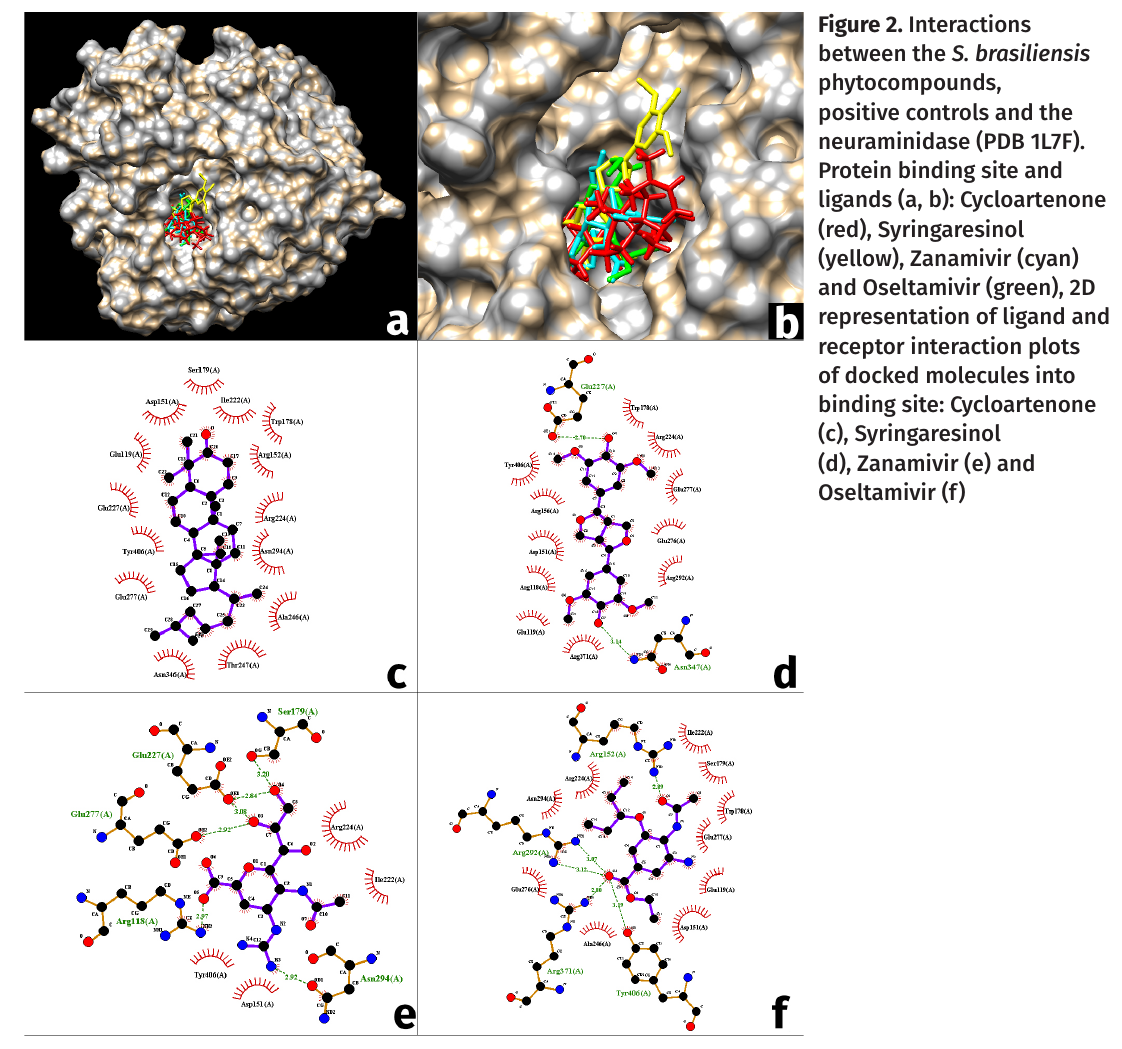
Figure 2. Interactions between the S. brasiliensis phytocompounds, positive controls and the neuraminidase (PDB 1L7F). Protein binding site and ligands (a, b): Cycloartenone (red), Syringaresinol (yellow), Zanamivir (cyan) and Oseltamivir (green), 2D representation of ligand and receptor interaction plots of docked molecules into binding site: Cycloartenone (c), Syringaresinol (d), Zanamivir (e) and Oseltamivir